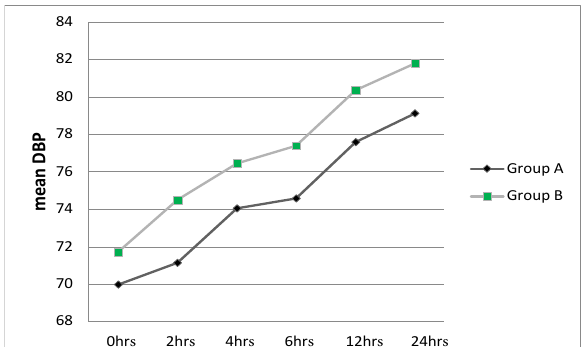
Fig 3. Comparison of mean DBP at different time periods (Table